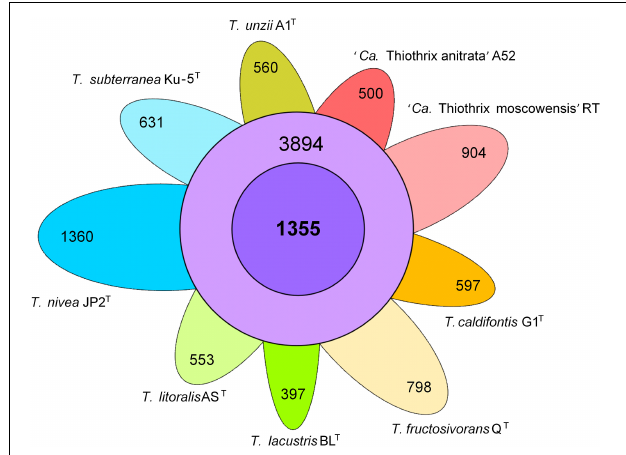
FIGURE 4 | Pangenome of the genus Thiothrix . Venn diagram demonstrating the distribution of common (purple), additional (violet), and unique (different colors) genes among analyzed Thiothrix